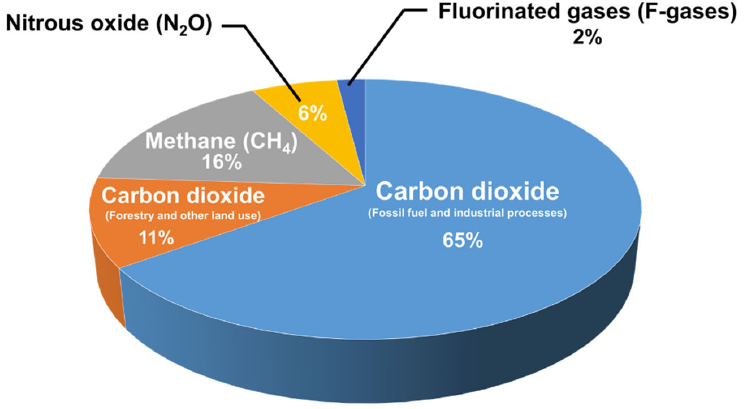
Figure 1. Global greenhouse gas (GHG) emissions based on global emissions from 2010 reported in the Contribution of Working Group III to the Fifth Assessment Report of the Intergovernmental Panel on Climate Change [4].